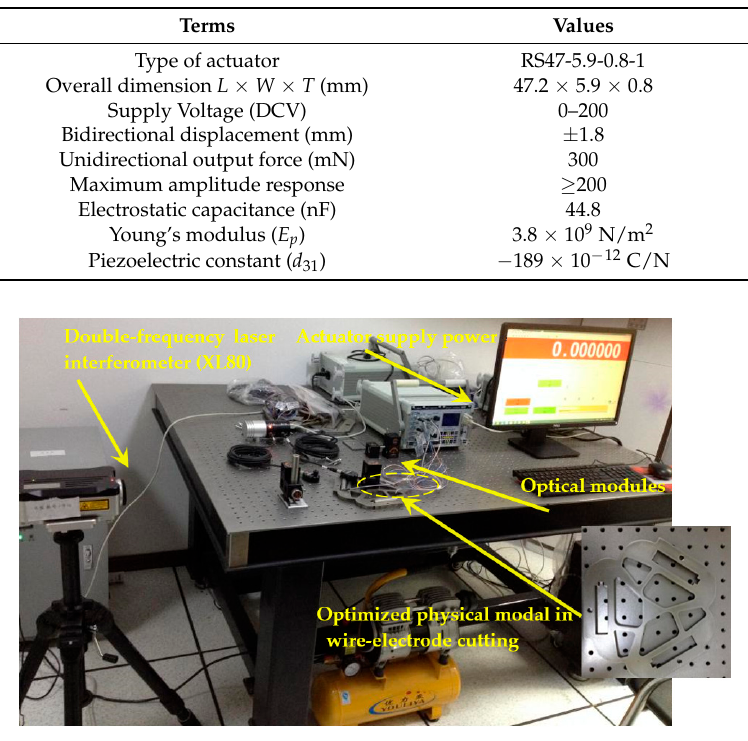
Figure 20. The physical model of the optimized material and PZT actuator. Table 6. The parameters of PZT actuator.